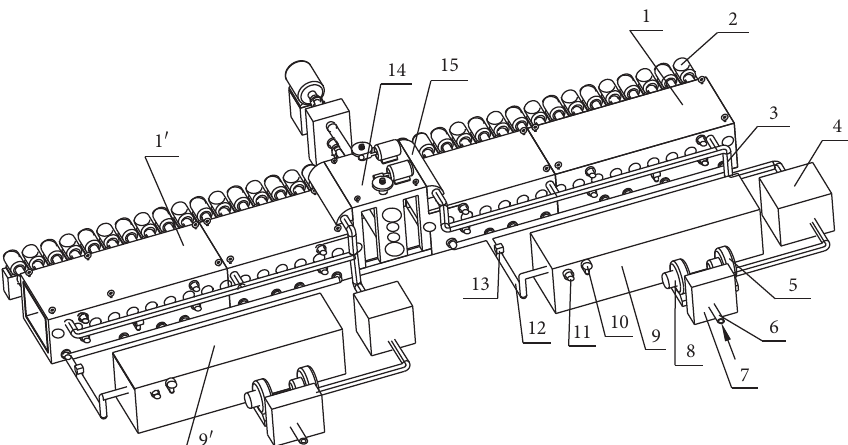
Figure 4: A schematic diagram of the three-dimensional structure of the hot air edge temperature compensation roller incubator for rolling the magnesium alloy.1, roller table; 2, roller motor; 3, heat recycling pipe; 4, filter; 5 and 8, blower; 6, replenishment pipeline; 7, filter; 9, heat preparation box; 10, pressure sensor; 11, temperature sensor; 12, hot air pipeline; 13, high-temperature speed control valve; 14, rolling machine; 15, heat recycling device mounted on the